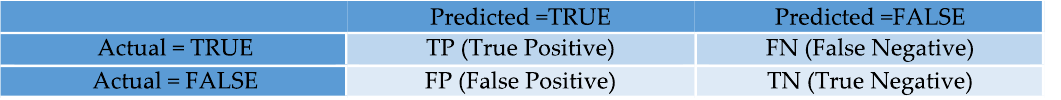
Figure 9. Predicted true/false values and actual true/false values.